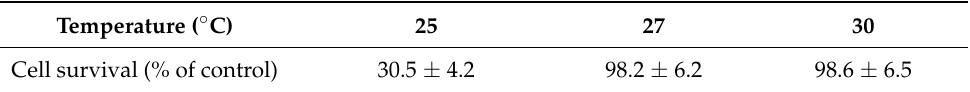
Table 2. Cell resilience to temperature. Cell survival percentage of huMPCs cultured in the EUs at the indicated T for 5 days with respect to huMPCs cultured in parallel at 37 ◦ C in plates (control). Temperature ( ◦ C)